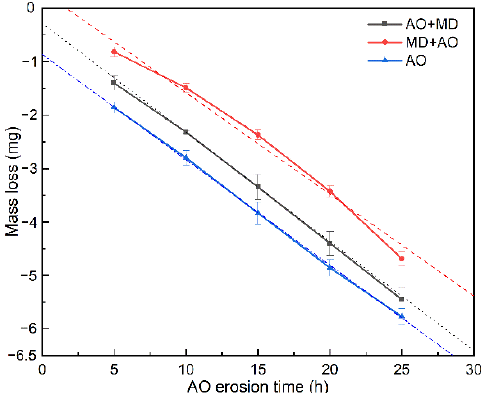
Figure 6. Weight loss curve of Kapton film before and after different load spectrum tests.